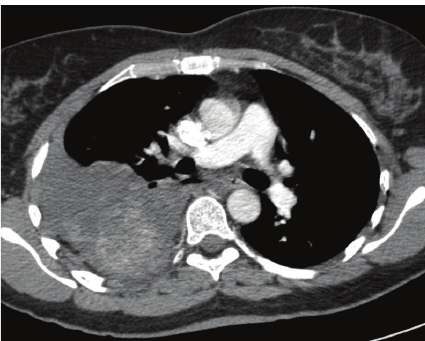
Figure 1: CT scan showing a right pleural effusion consistent with a haemothorax due to recent and active bleeding associated with a paravertebral hyperdense formation (7cm in diameter) suspected to be a parietal neoplasm.